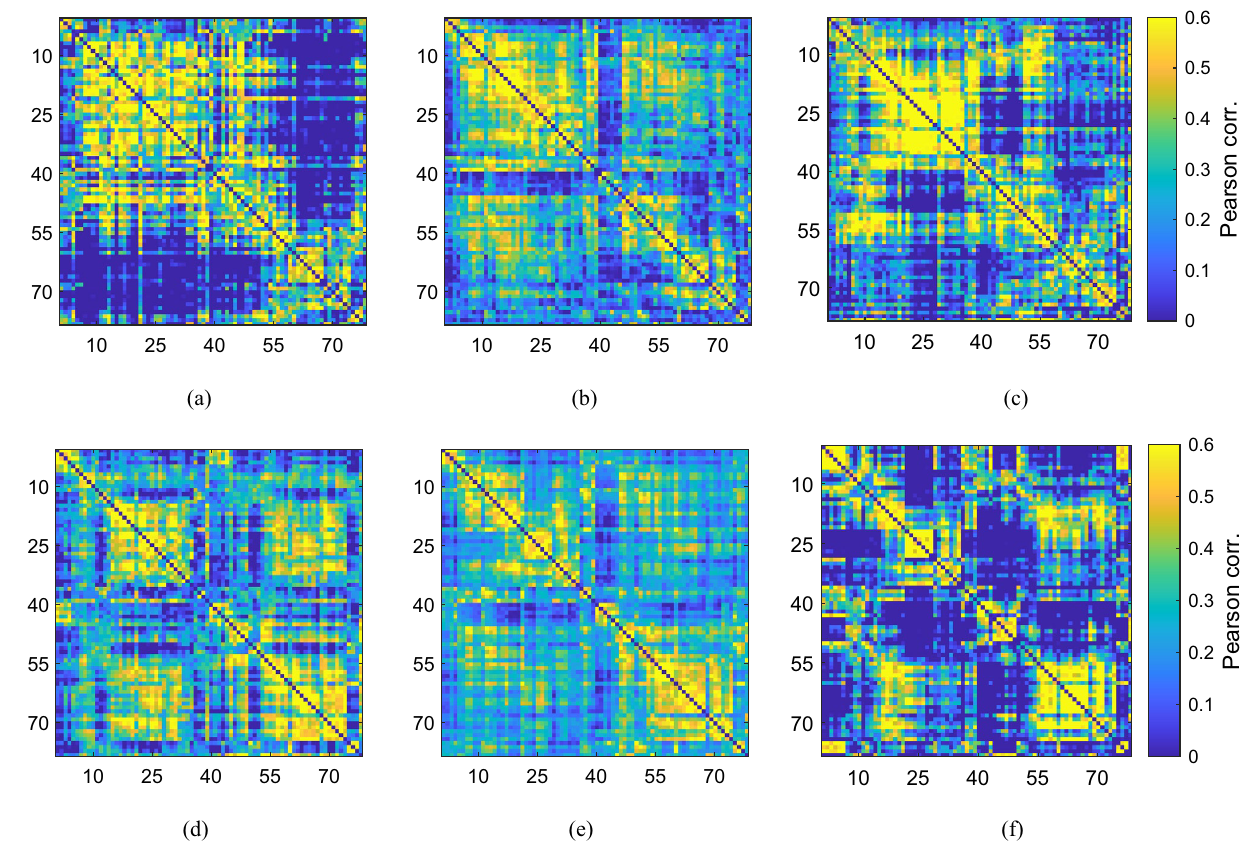
Figure 5. Simulated functional connectivity matrices deploying the weighted structural network with specific parameter values ( P , Q ) = ( − 1.83, − 3.94 ) , which are highlighted by a circle in Fig. 3d. For these parameter values the network is capable of attaining a range of functional configurations, ( a – f ), under variation of the initial conditions. Across 100 realisations, we observe deviations in the Jaccard index of 50% around a mean value ∼ 0.02